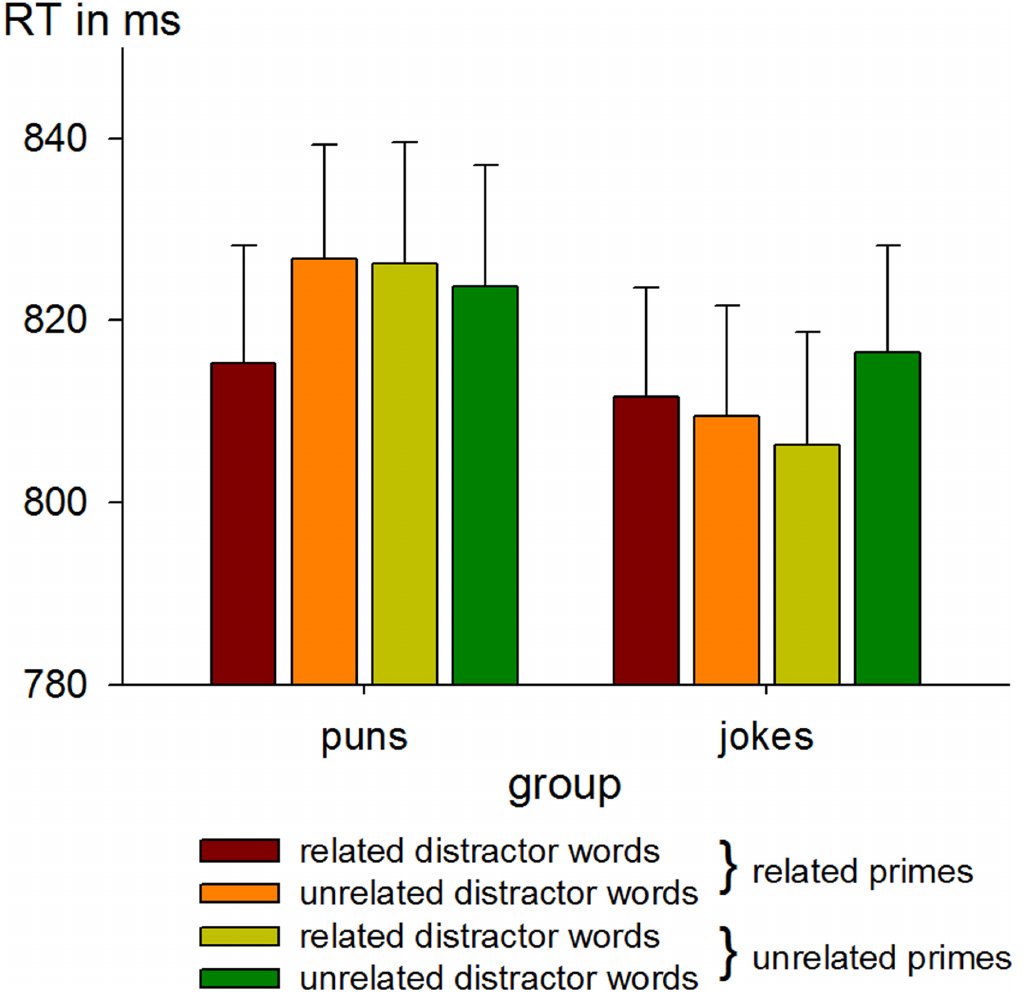
Fig 3. Naming latencies and standard error bars in the puns and jokes group depending on distractor word and prime